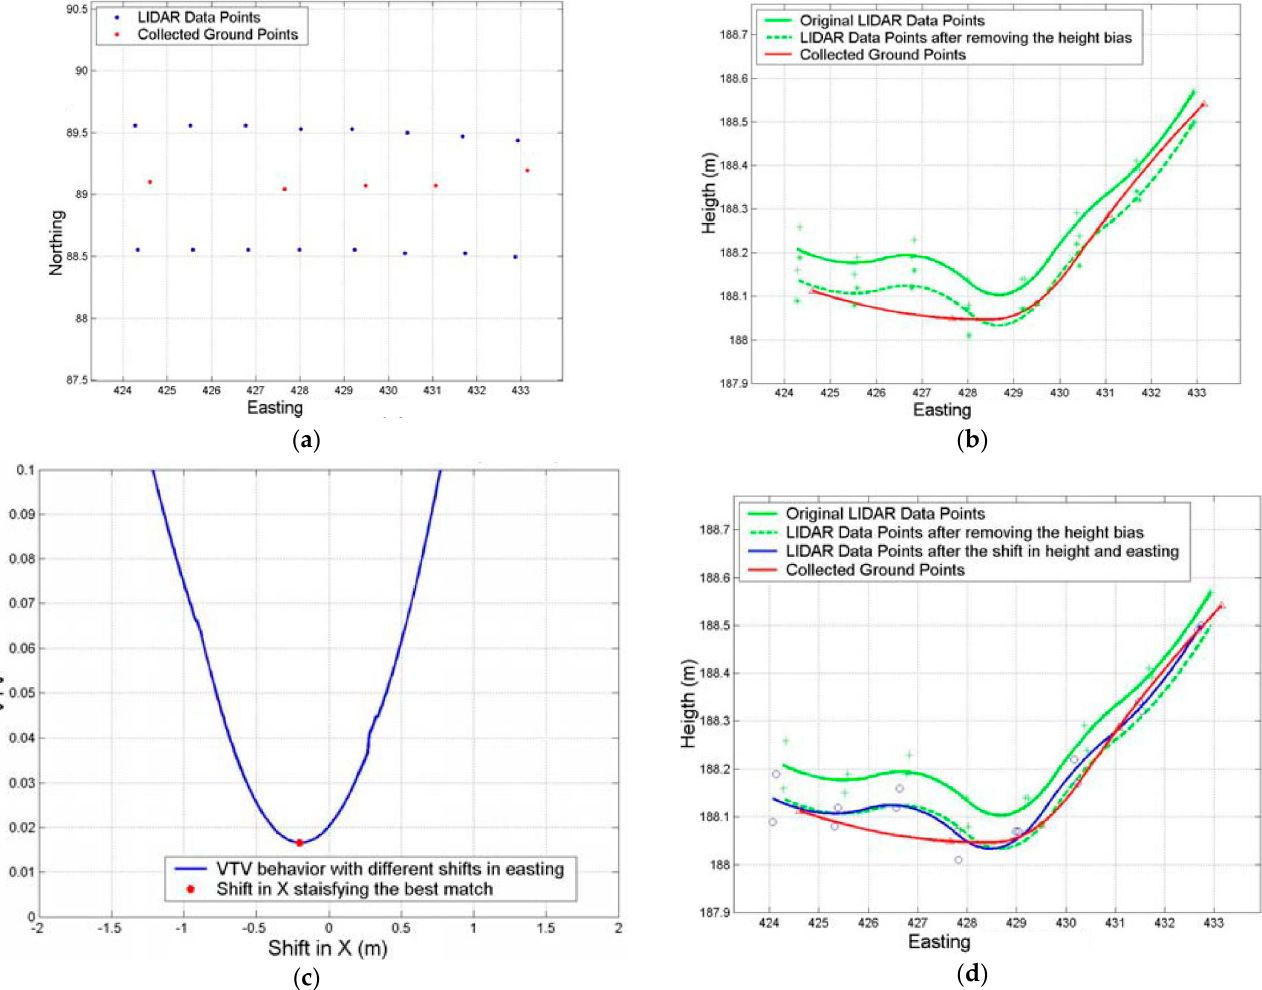
Figure 10. ( a–d ) Planimetric offset in Easting (X) direction at location B.